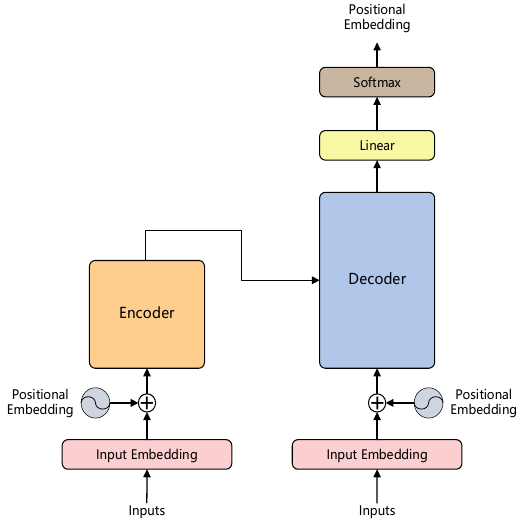
Sensors 2022 , 22 , x FOR PEER REVIEW Figure 3. The architecture of transformer model. Figure 3. The architecture of transformer model.